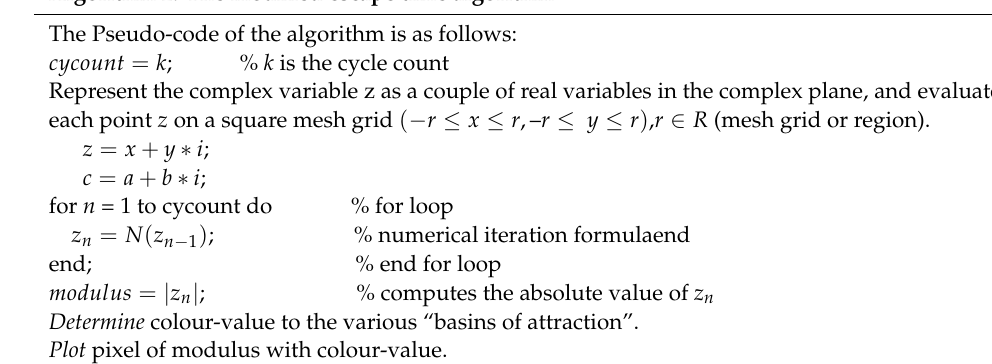
Algorithm 2: The modified escape time algorithm